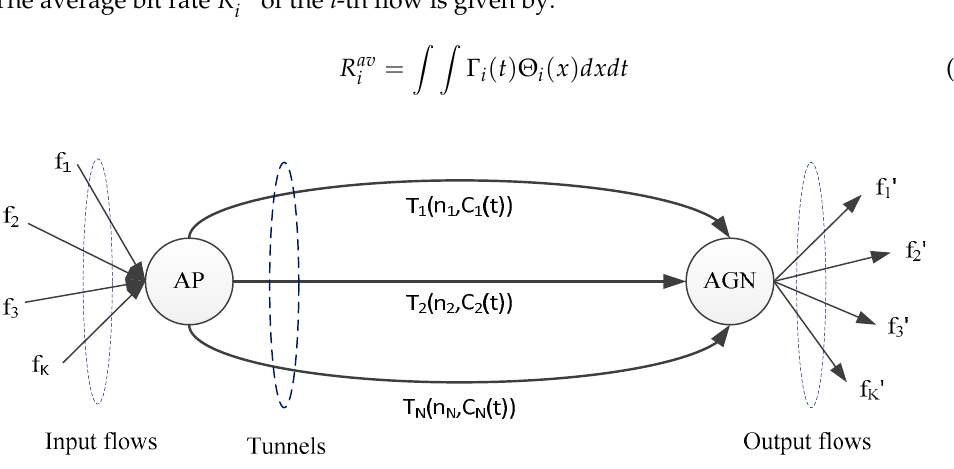
Figure 3. The system model of the considered networking scenario.